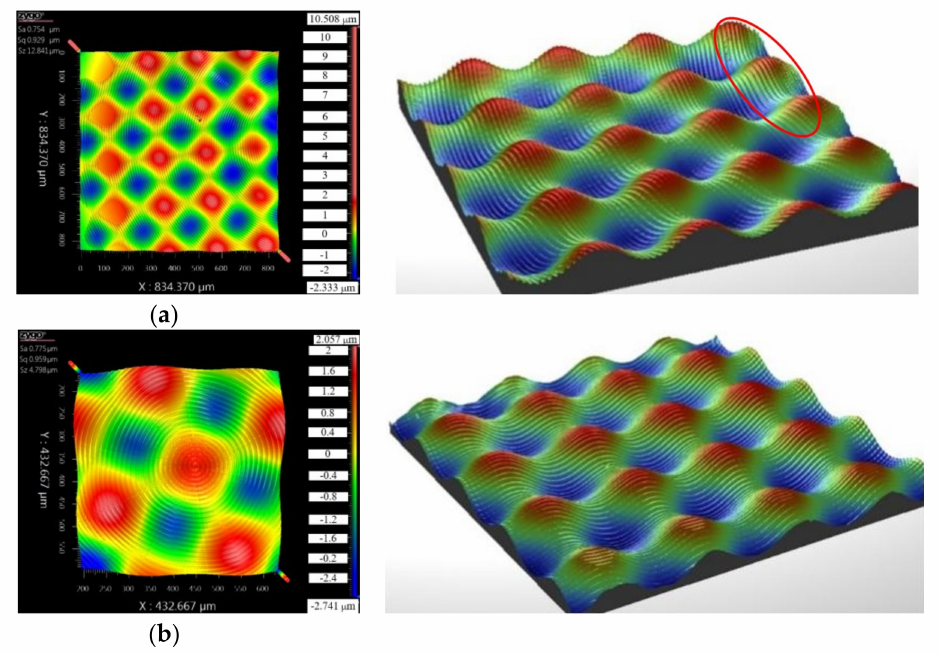
Figure 5. Profile of fabricated sinusoidal microstructures by ( a ) the FTS system and ( b ) the FTS system and the rotary B